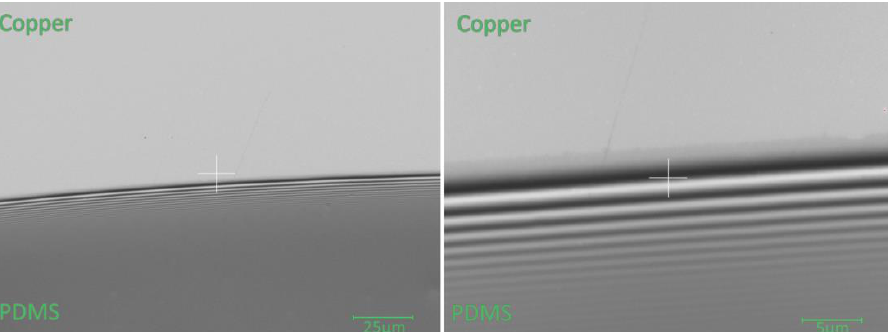
Figure 5. Edge of the PDMS droplet on siliconized Cu exhibits a homogeneous and sharp edge ( left ). At higher magnification ( right ), a thin film can be seen emerging from the edge. This film is assumed to have negligible influence on the macroscopic view of interface diffusion.